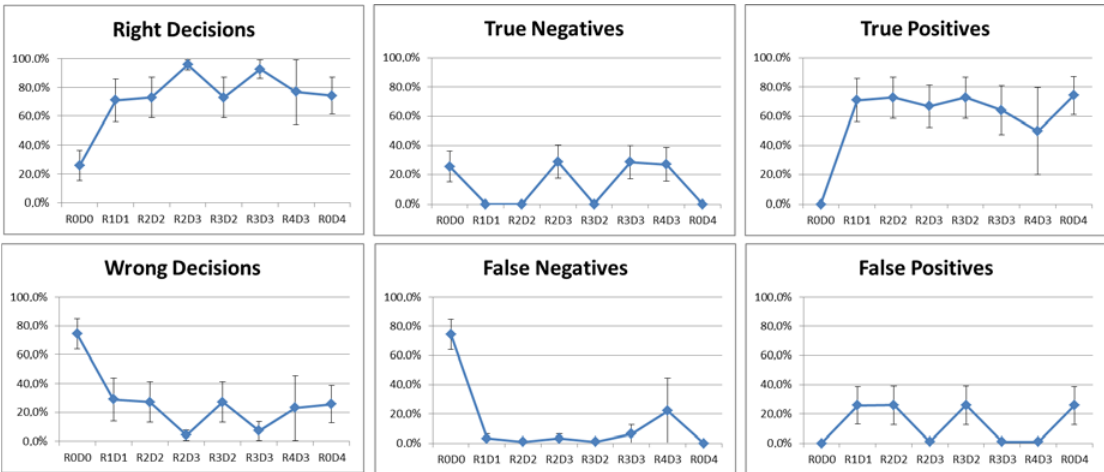
Figure 6. Newcomer attack for restricted scenario experiments.